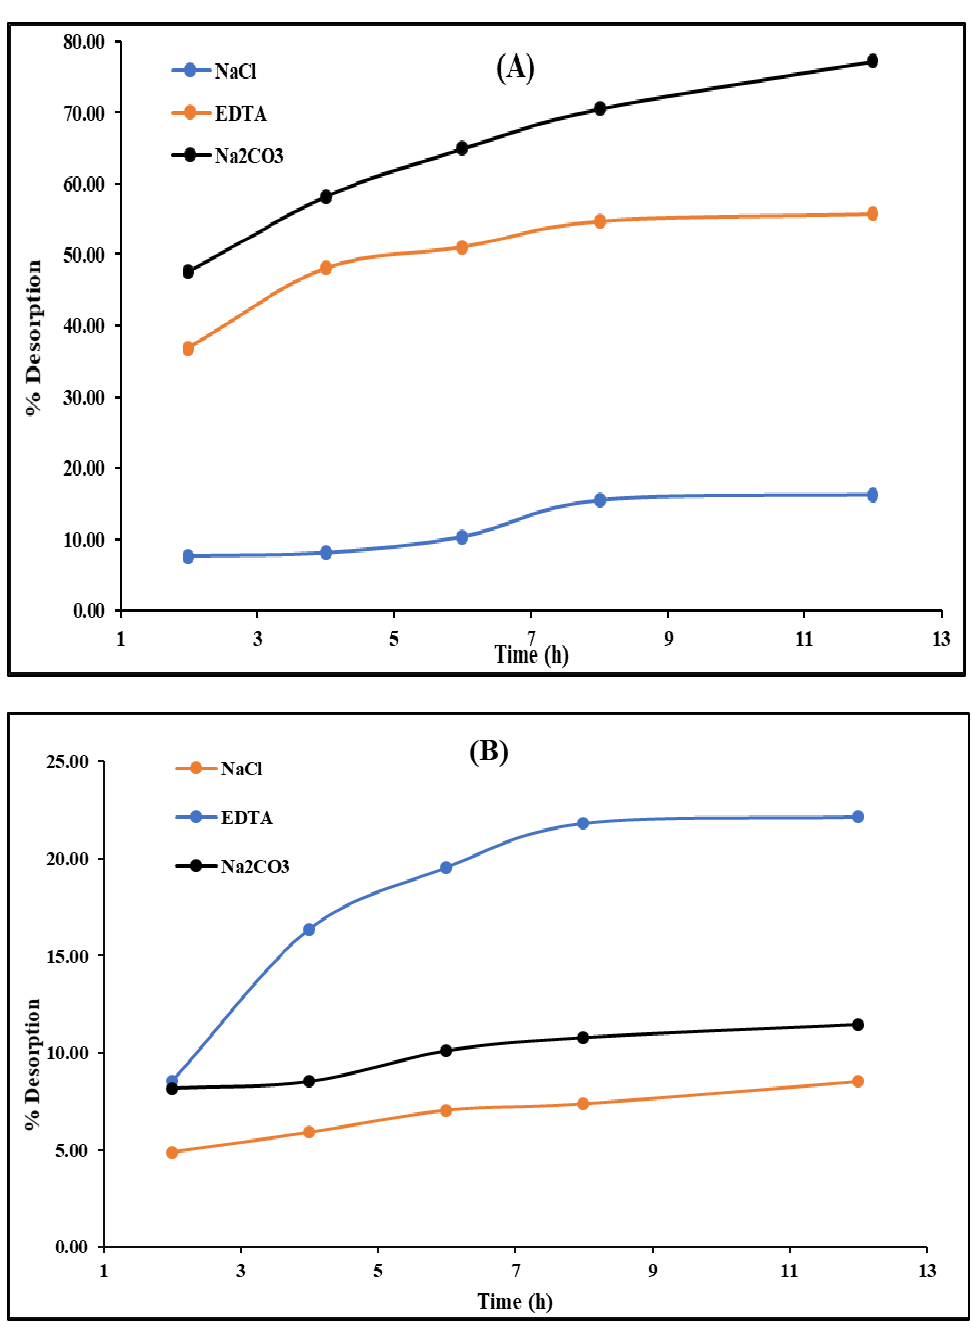
Figure 15. Reusability of CCsMFO nanocomposite from adsorbed ( A ) U(VI) and ( B ) Th(IV) ions.